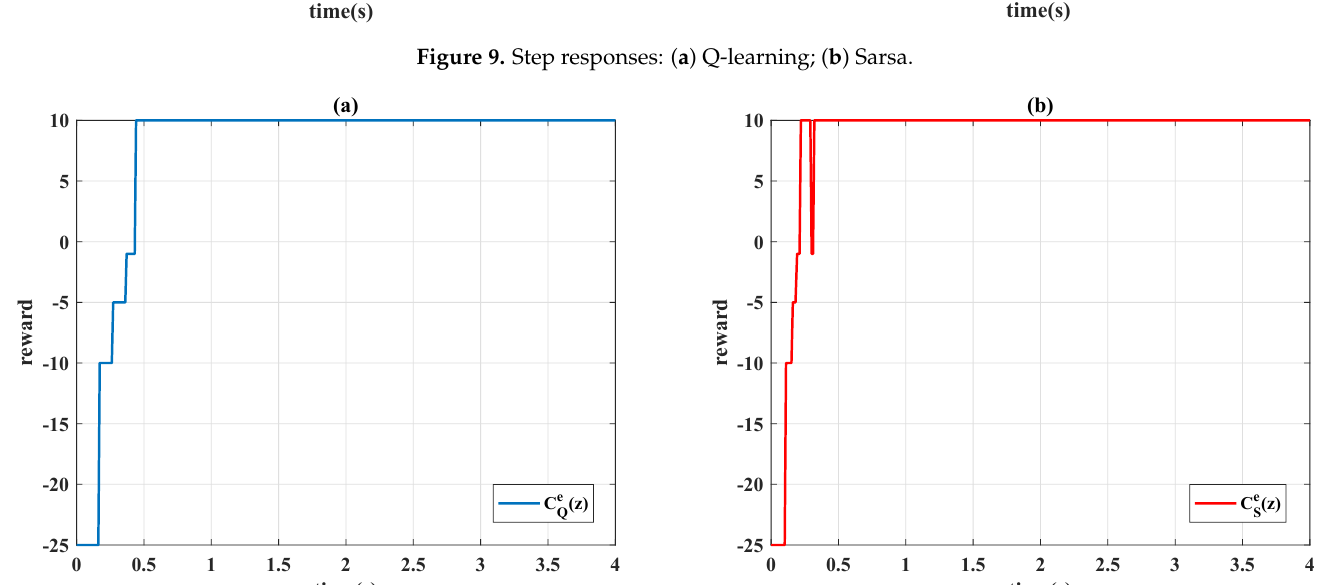
Figure 10. Learning curves with p t = e t : ( a ) Q-learning C e